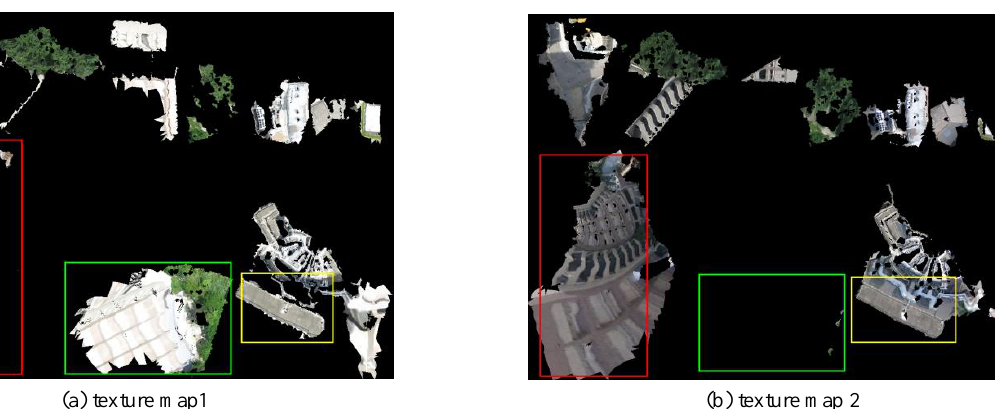
Fig.5. Results of texture atlas